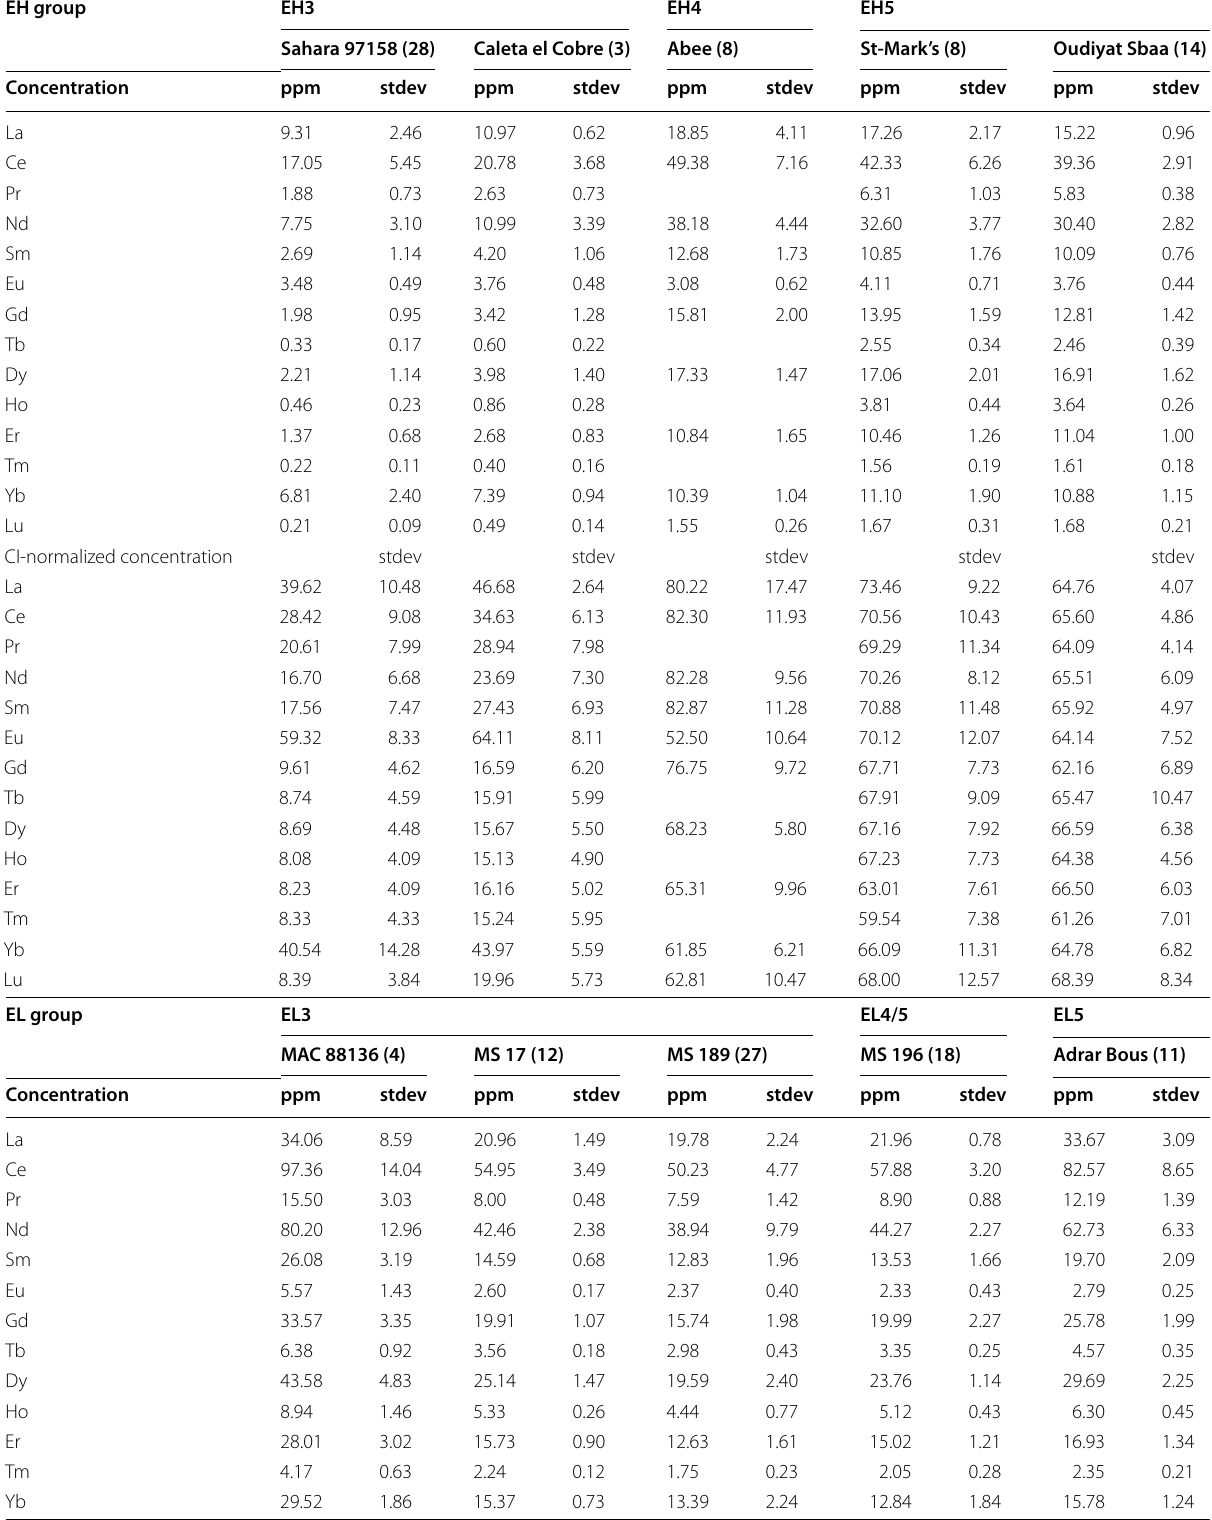
Table 2 Rare-earth element concentrations measured in CaS (in ppm) and CI-normalized values EH group EH3 EH4